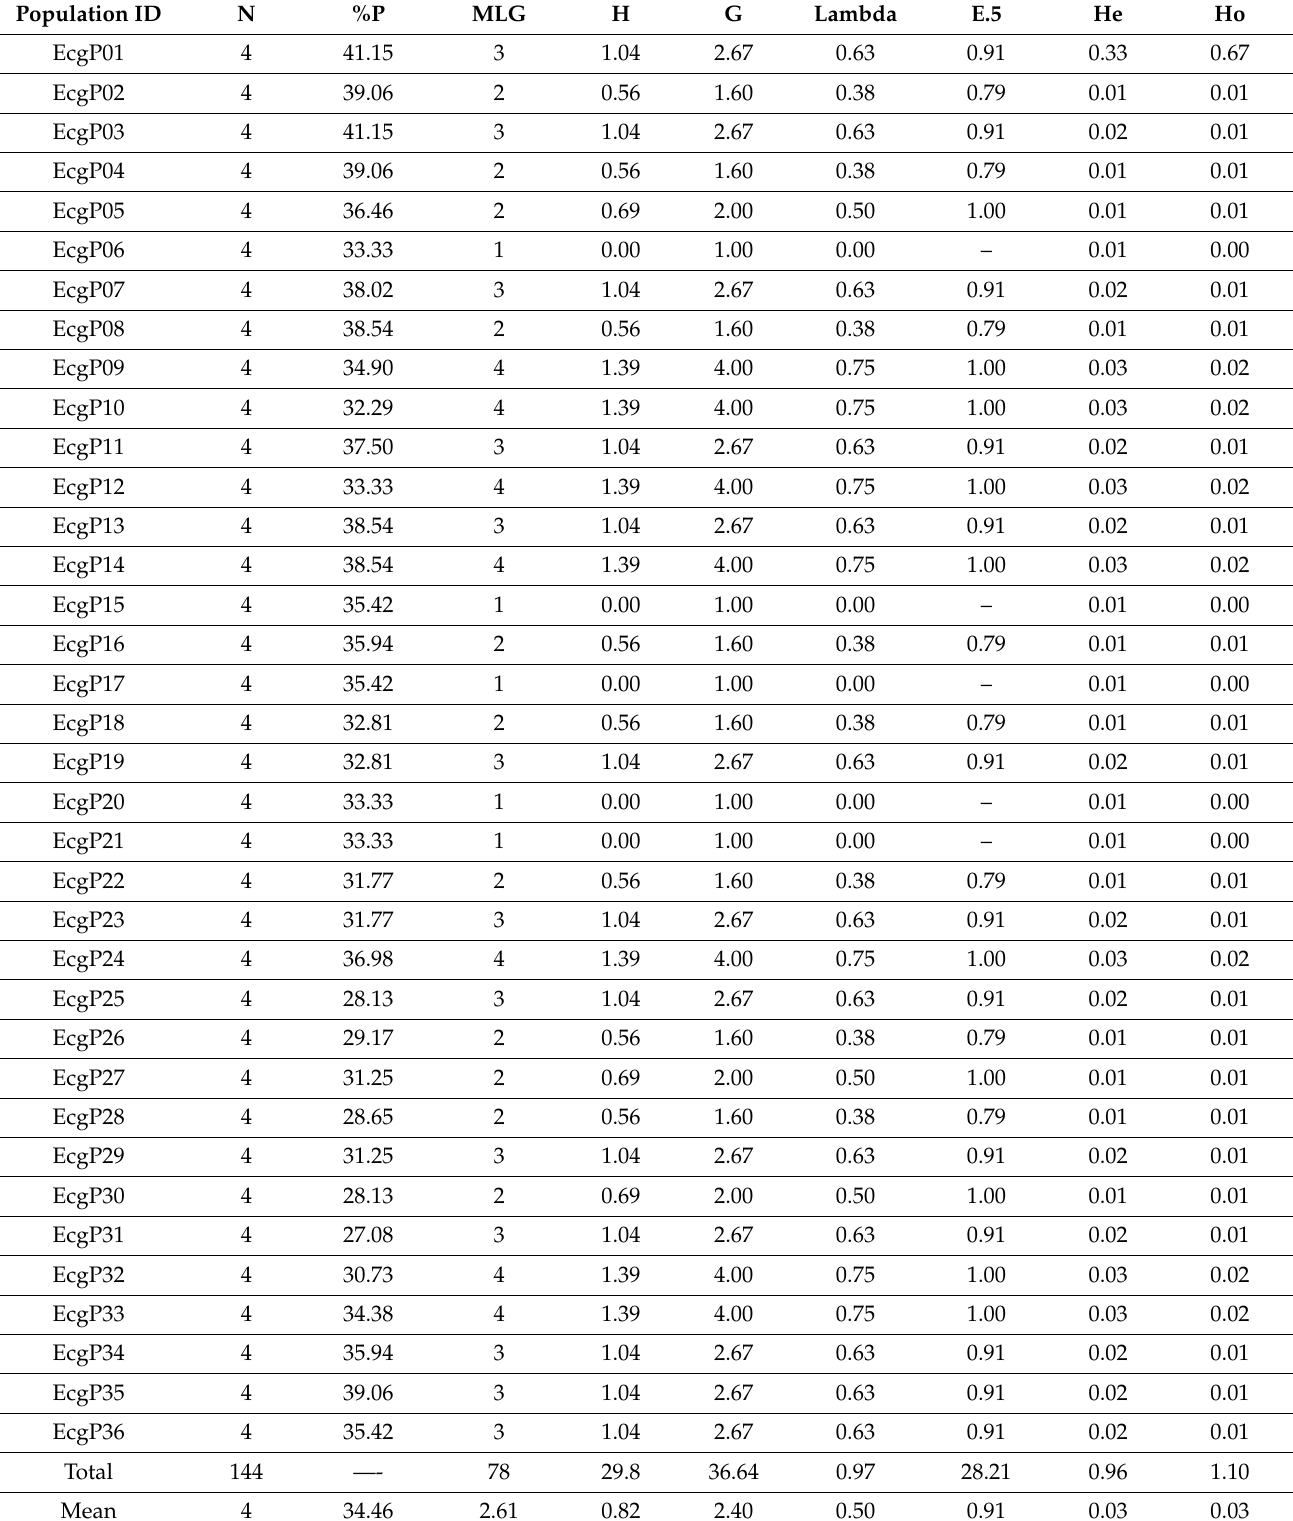
Table 5. Genetic diversity parameters in Echinochloa crus-galli